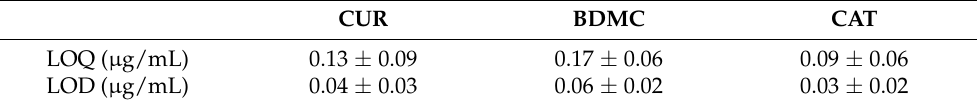
Table 2. Detection and quantification limits of the analytical method for curcuminoids. CUR BDMC CAT LOQ ( µ g/mL)